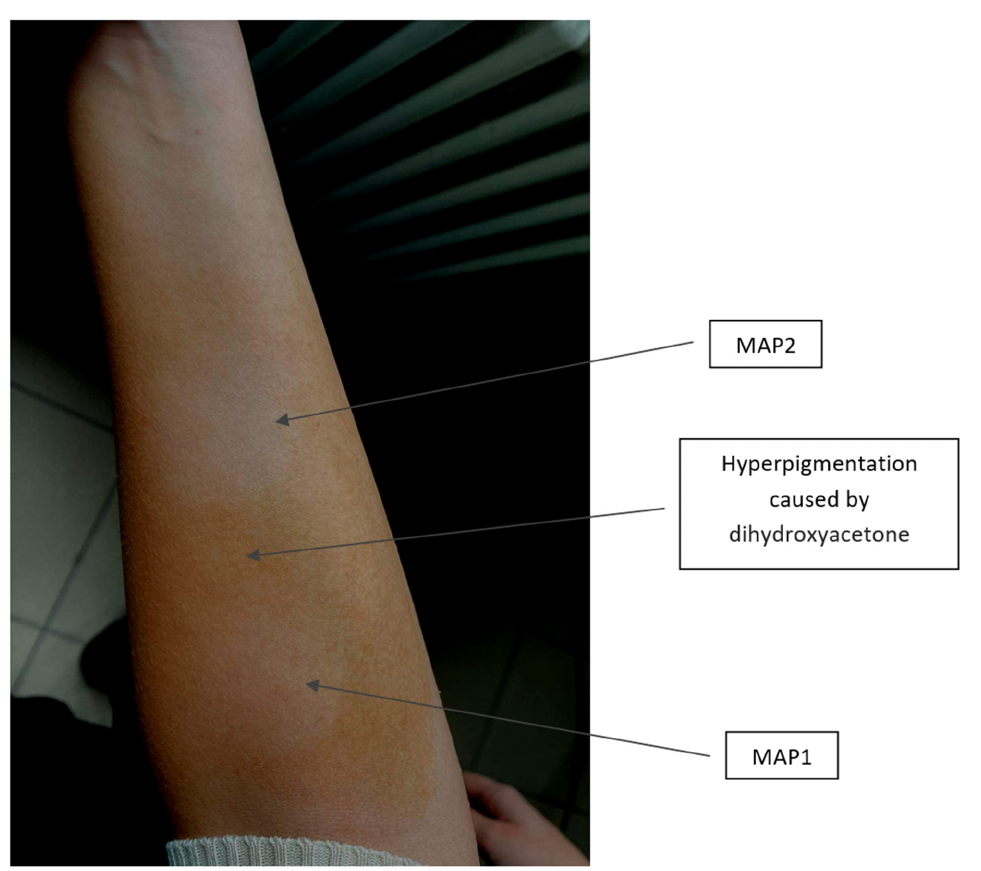
Figure 5. Hyperpigmentation caused by dihydroxyacetone and lightening of the skin caused by the application of MAP1 and MAP2.